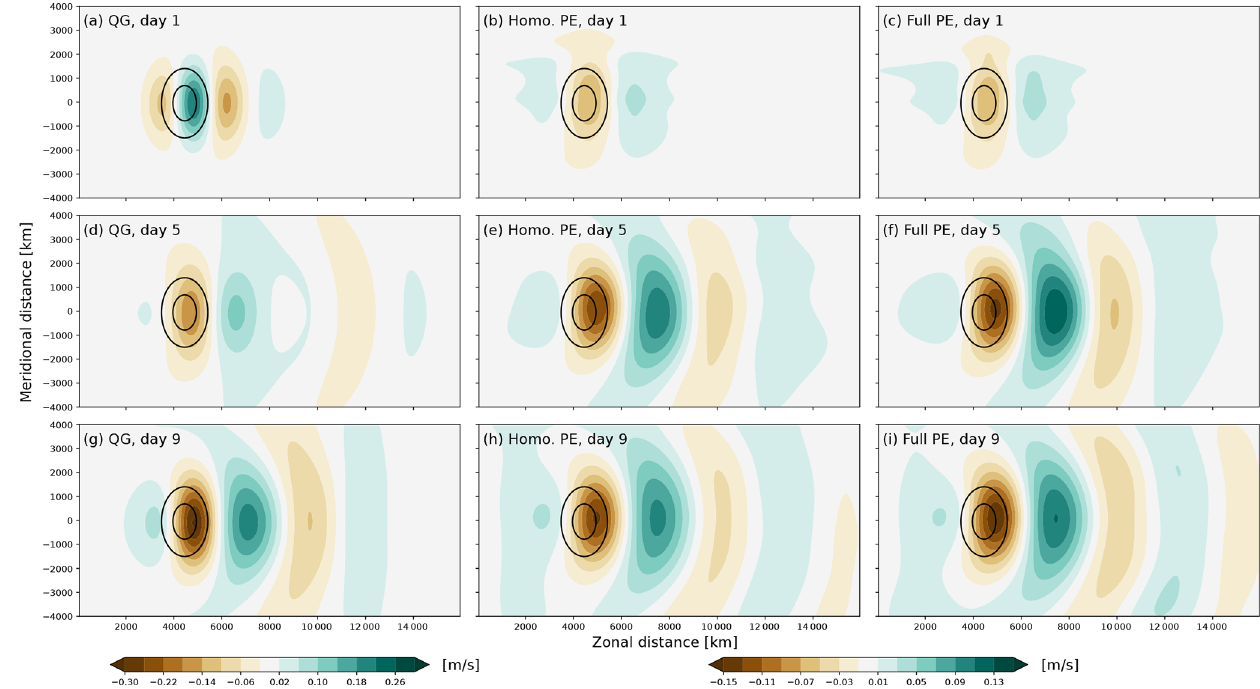
Figure 7. Developing stationary Rossby wave response to orographic forcing on a β plane for (a, d, g) QG, (b, e, h) homogeneous-density PE, and (c, f, i) full PE. From top to bottom, the rows show the development after (a–c) 1d, (d–f) 5d, and (g–i) 9d lead time. The shading shows the meridional wind at σ = 0 . 75 in ms − 1 . The contours show the orography by the 4 and 8m contours. Note that the entire model domain is not shown in the y direction.